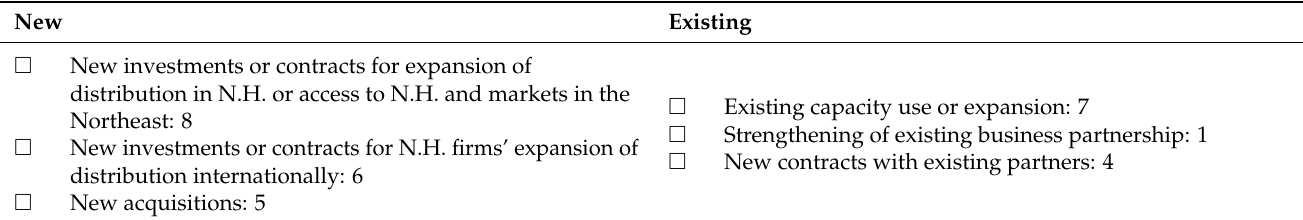
Table 6. New versus existing investments of foreign firms in N.H. or with N.H. businesses. New Existing New investments or contracts for expansion